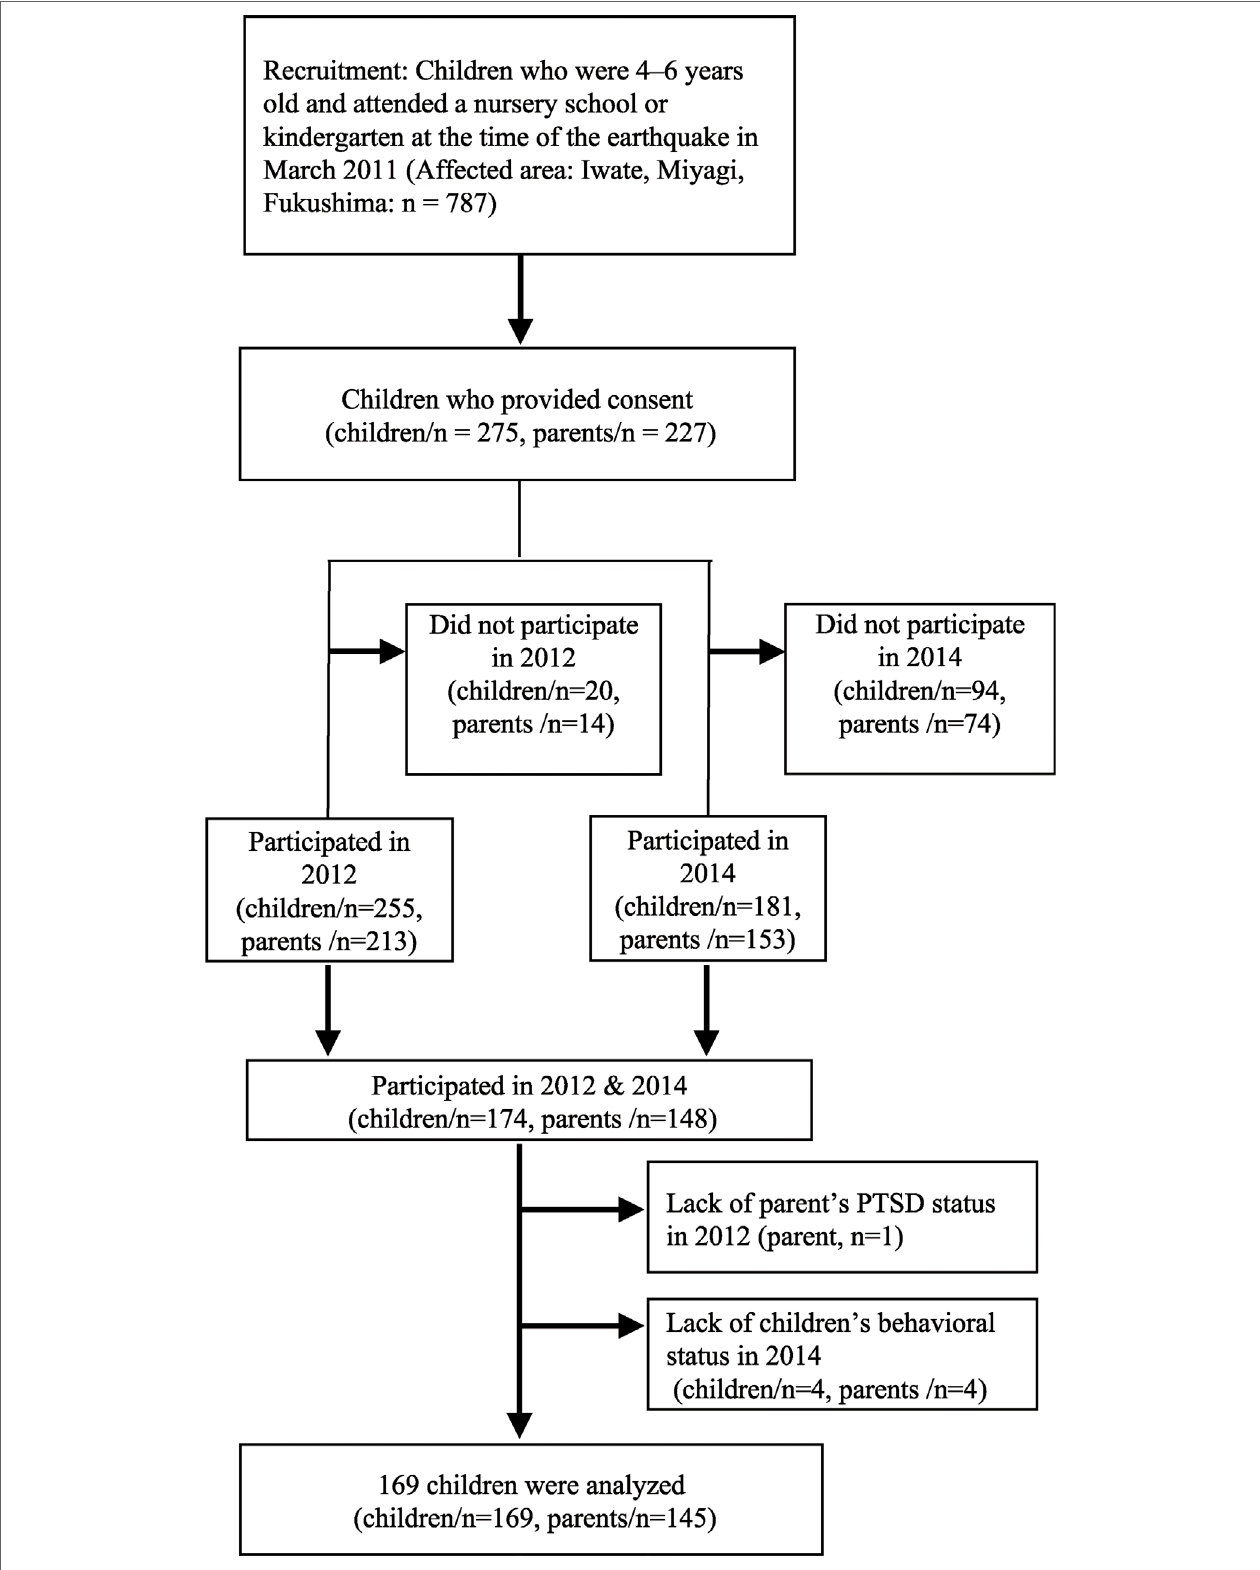
FIGURE 1 | Flowchart of the sample selection